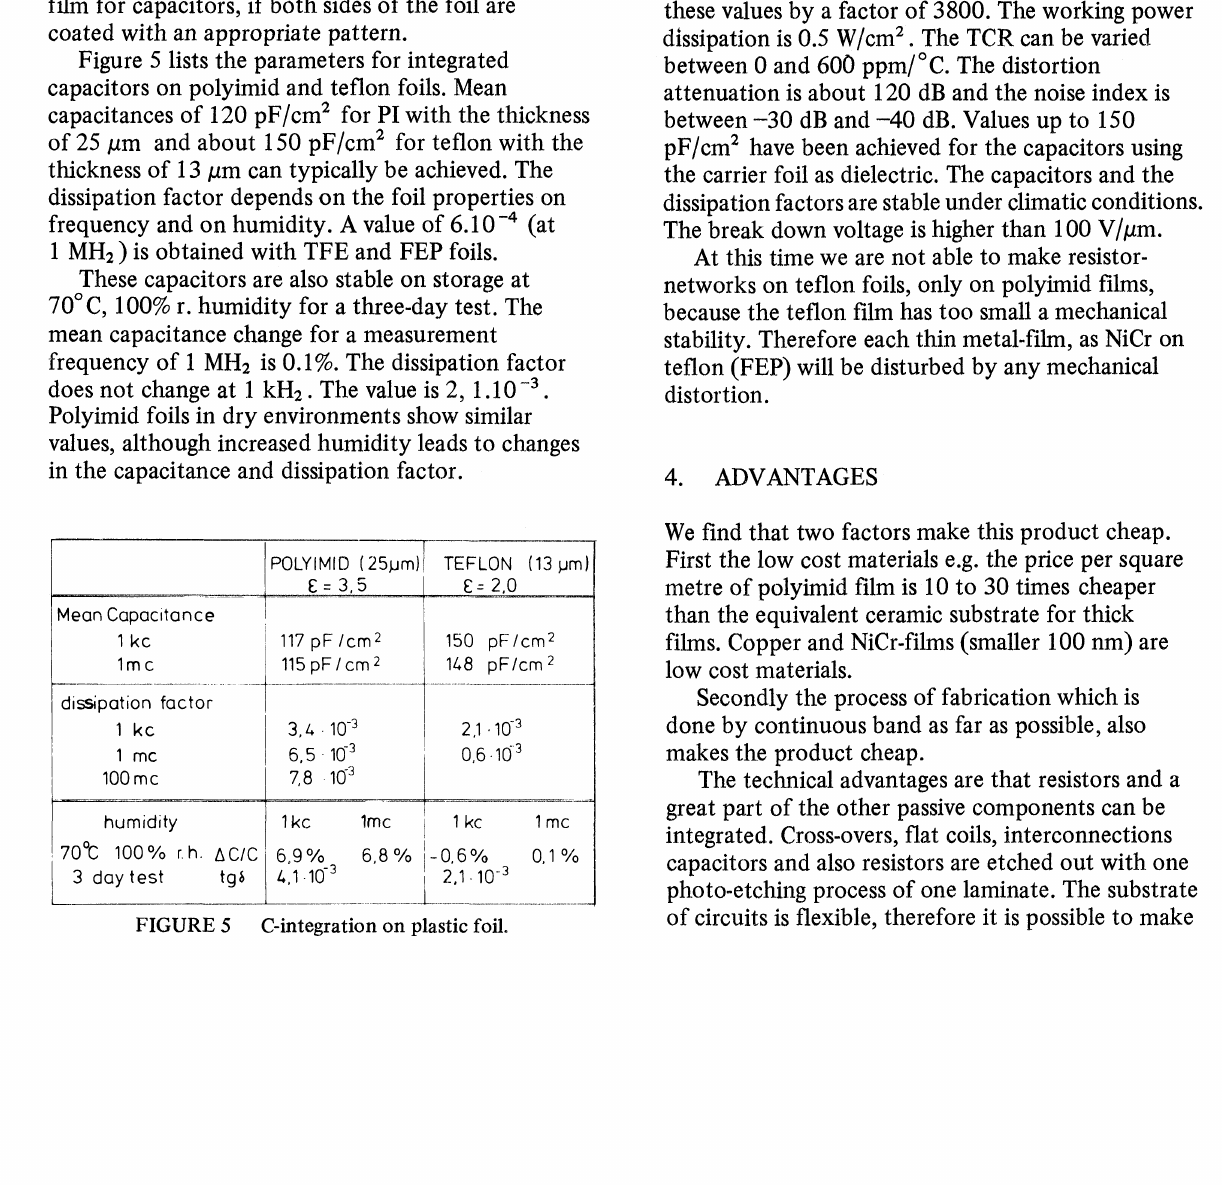
FIGURE 4 CrNi-films.